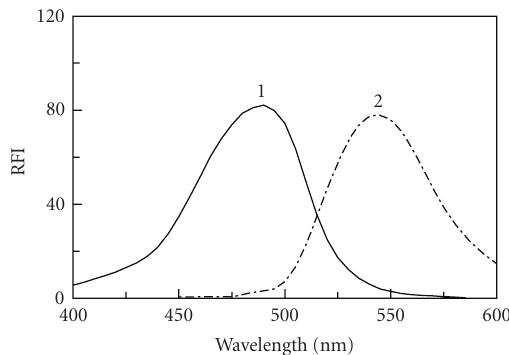
Figure 2: Excitation (1) and emission (2) spectra of FLX (0.03 μ g mL − 1 ) and its reaction product with NBD-Cl (0.2%, w/v) against reagent blank.